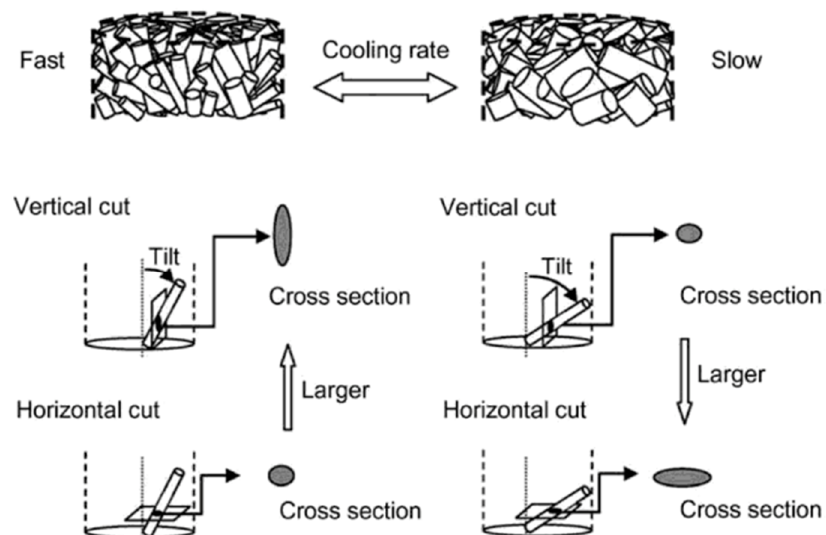
Figure 1. Schematic view of vertical and horizontal cross-sections of samples obtained through fast and slow freezing temperature. (Reprinted with permission from Chemical Engineering Research and Design, Vol. 89, Huihua Liu, Kyuya Nakagawa, Deeptangshu Chaudhary, Yusuke Asakuma, Moses